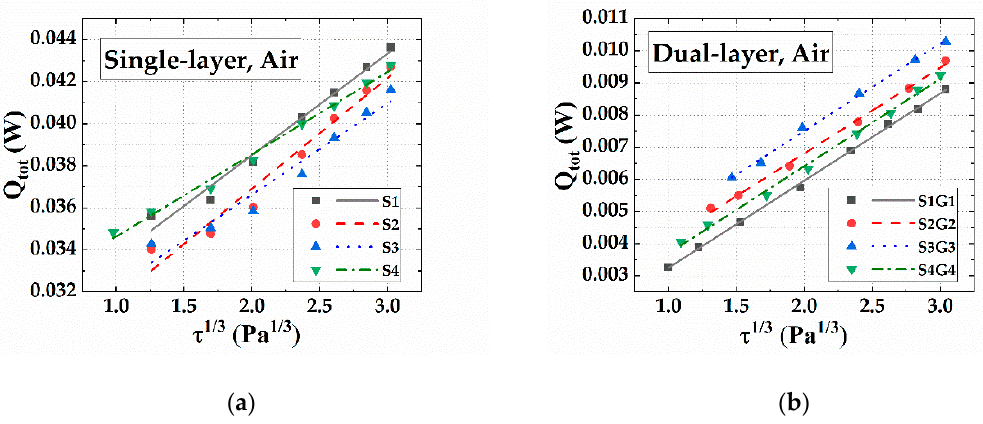
Figure 7. The calibration results of the ( a ) single-layer and ( b ) dual-layer flexible hot film sensors.